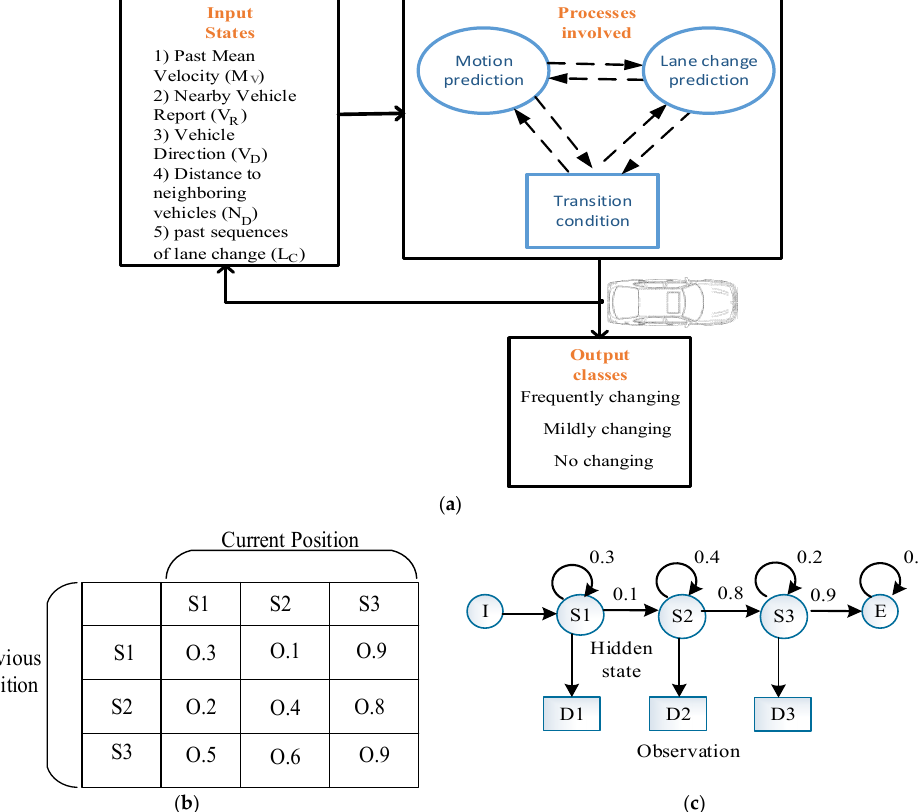
Figure 3. ( a ) conceptual diagram, ( b ) state positions, ( c ) hidden Markov model.